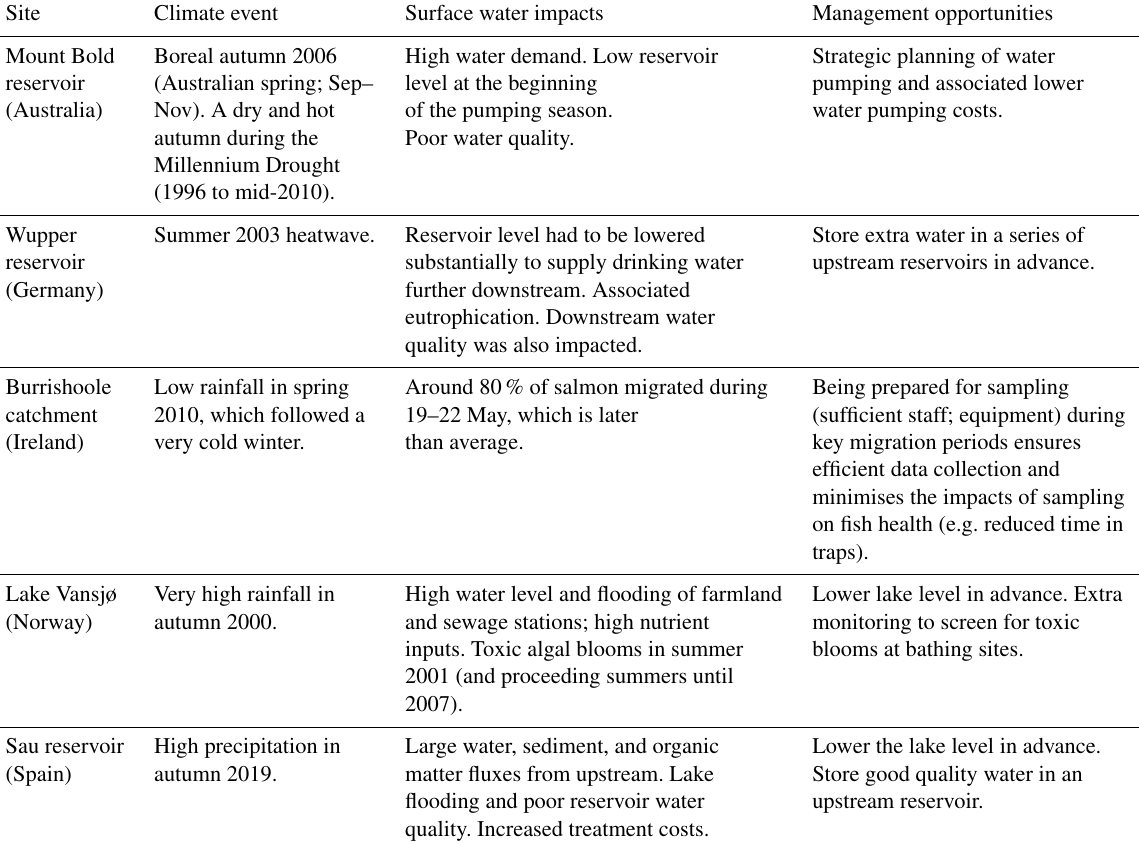
Table 2. Seasonal events selected by water managers, associated surface water impacts, and management opportunities identified (had advance warning been available at the